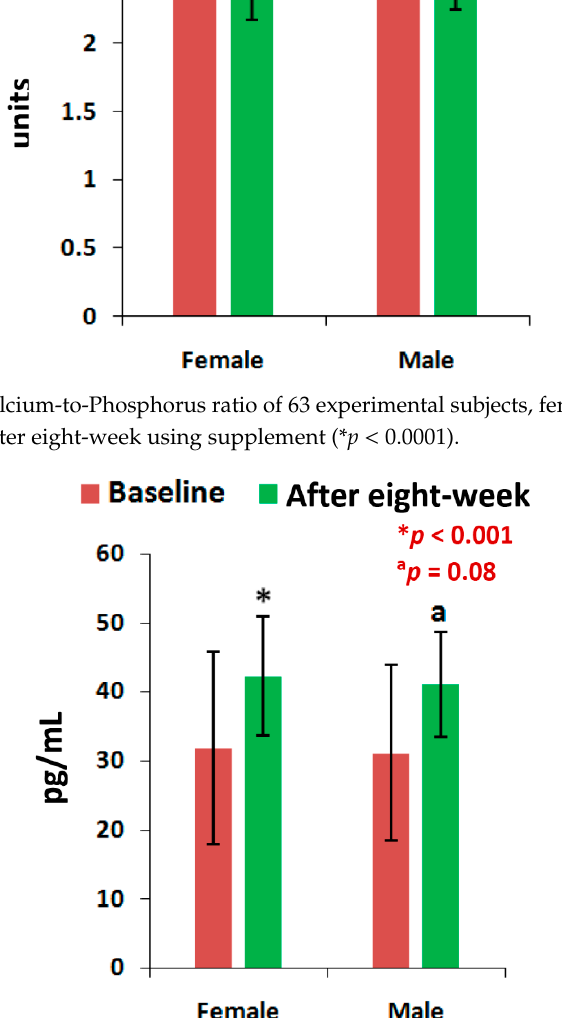
Figure 4. Levels of Vitamin ‐ D of 63 experimental subjects, female ( n = 39 ) and male ( n = 24), before and after eight ‐ week using supplement ( ᵃ p = 0.12, ᵇ p = 0.26). Table 2 shows the levels of correlation coefficients between the ratio of calcium ‐ to ‐ phosphorus at the baseline (CPR b ) and at the end of eight ‐ week treatment with supplement (CPR t ), were negatively correlated but not significant ( p = 0.286 for females and p = 0.346 for males) while that of the levels of PTH and vitamin D were all highly significant ( p < 0.01) for both female ‐ only and male ‐ only. The correlation coefficients between all the biochemical parameters of the control subjects at the baseline and at the end of eight ‐ weeks without supplement for female ‐ only patients and male ‐ only patients were not significant. Table 3 shows that the percentage of co ‐ efficient of variances for all the studied biochemical parameters of the experimental subjects with supplements were substantially reduced compared to the control subjects without supplements.